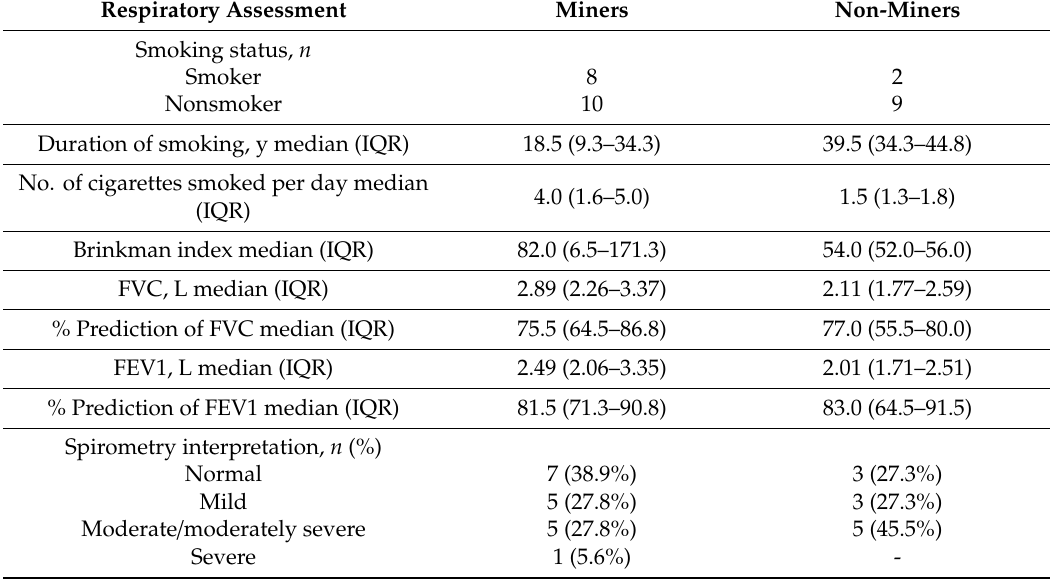
Table 3. Respiratory assessment including smoking status and parameters of spirometry